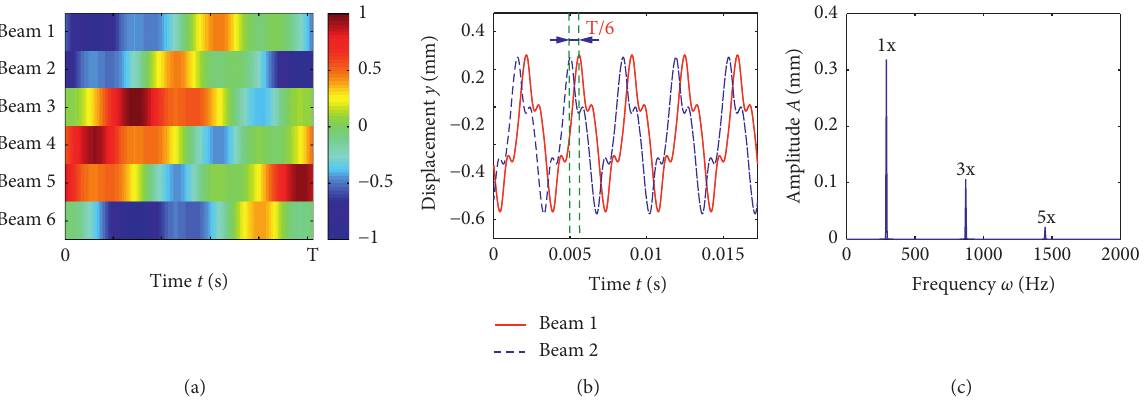
Figure 20: The response of beam root for μ � 0.3: (a) response of beam 1 to beam 6, (b) response curve of beams 1 and 2, and (c) spectrum plot of beam 1.